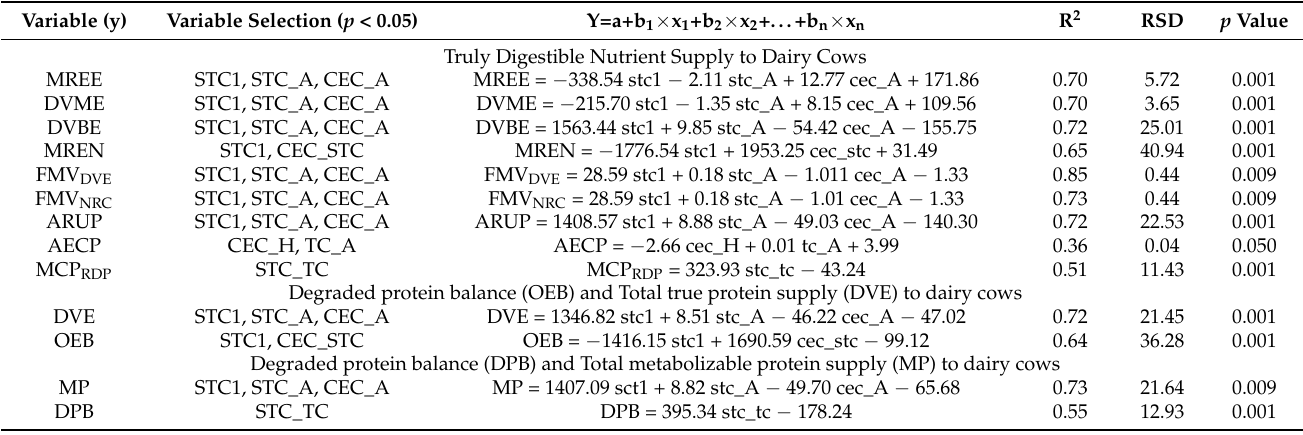
Table 7. Multiple Regression Analysis to Study Associations between Carbohydrate Spectral Parame- ters and Truly Absorbed Protein, Intestinal Protein Degradation and Protein Rumen Degradation Kinetics of Cool-Season Adapted CDC